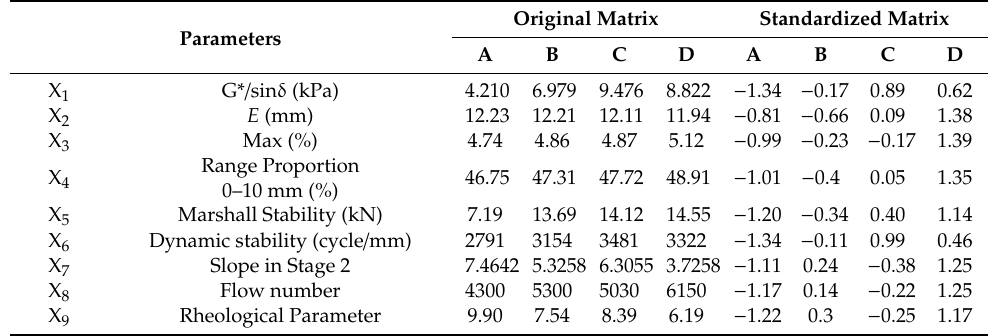
Table 6. Parameters selected for principal component analysis